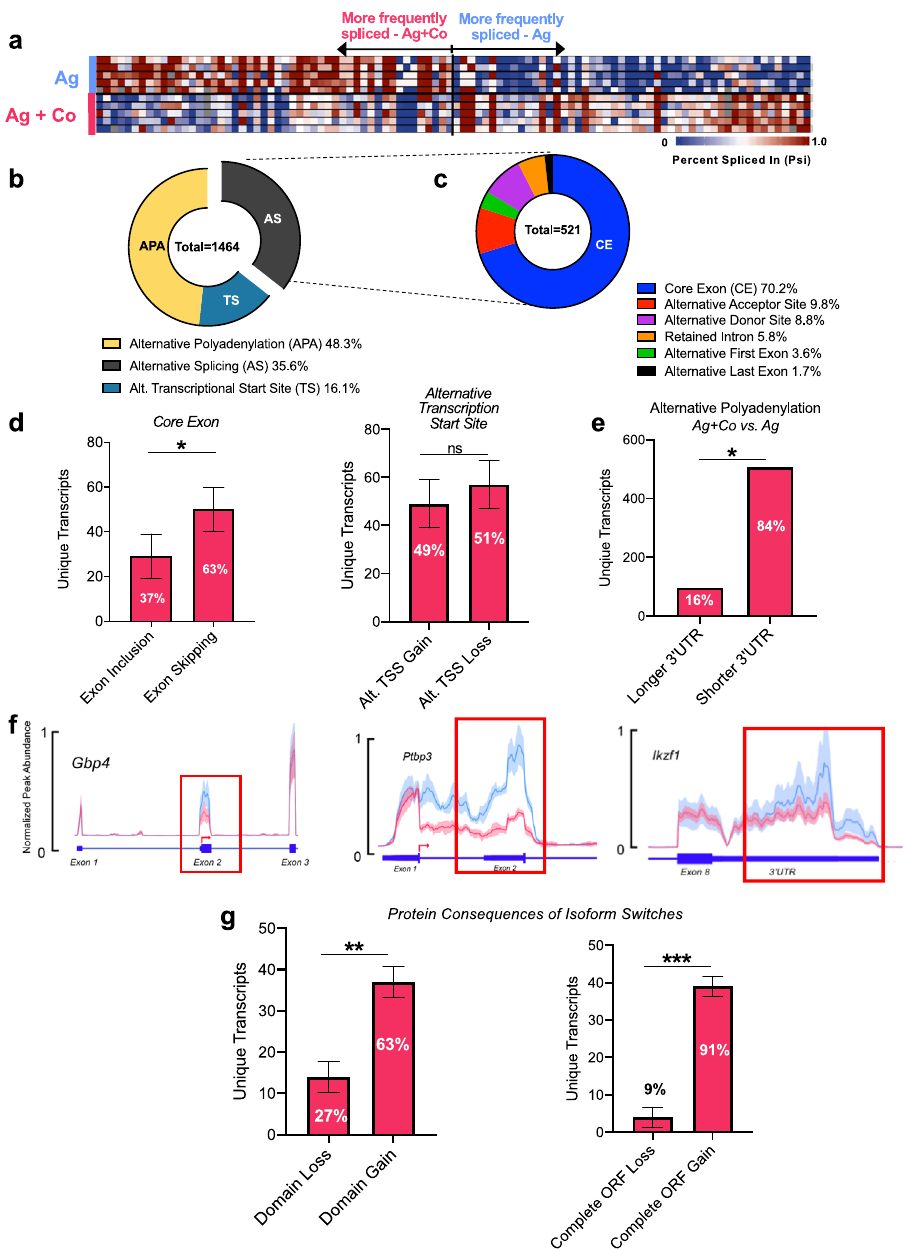
Fig. 2 Alternative splicing, alternative polyadenylation, and alternative transcriptional start sites are enriched after costimulation of CD8 + T cells. a Percent spliced in levels (Psi) of 1464 splice site differences in 950 genes between Ag and Ag + Costim groups (Probability > 0.9, Psi Diff > .05 or < − 0.05 after Whippet analysis of deep RNA-seq samples from Fig. 1, comparing antigen + costim and antigen alone groups (100 shown), n = 5 samples/group. Data is representative of 1 of 2 independent experiments. b Distribution of RNA alterations of events seen in a . c Distribution of alternative splicing events from ( b ). d Isoform switch analysis of splicing sites from deep RNA-seq samples in Fig. 1 showing enrichment of splicing event type between Ag + Costim and Ag groups. Percentages represent a fraction of the total number of exon splicing events between Ag + Costim and Ag groups i.e., 63% of exon splicing events were skipped exons (in the Ag + Co group) while 37% were included exons, n = 5 mice/group. e Analysis of alternative polyadenylation sites and 3 ′ UTR length between Ag + Costim and Ag groups, n = 5 samples/group. f Three examples of splicing events from IGV browser tracks of sequencing from ( a ). Peak abundance was normalized to exon nearest the splice site of interest. Shaded area represents standard deviation of n = 5 samples/group. Darker line represents the mean for each group. g Predicted protein consequences of isoform switches in ( a ), n = 5 samples/group. Data are presented as mean values + / − SE derived from two-sided Fisher ’ s exact test with Benjamini – Hochberg adjustment for multiple comparisons. Source data are provided as a Source Data fi